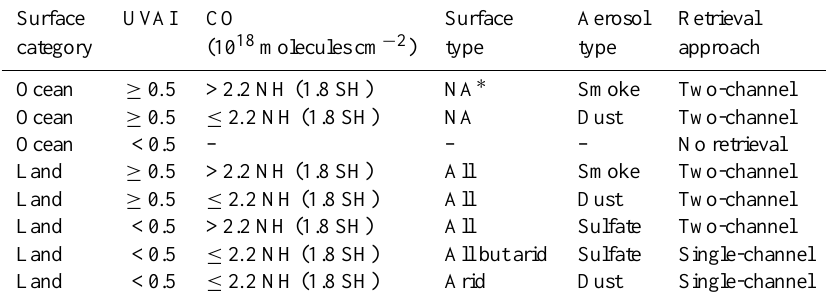
Table 3. Retrieval approach criteria of OMI near-UV algorithm version 1.5.3. Surface UVAI CO